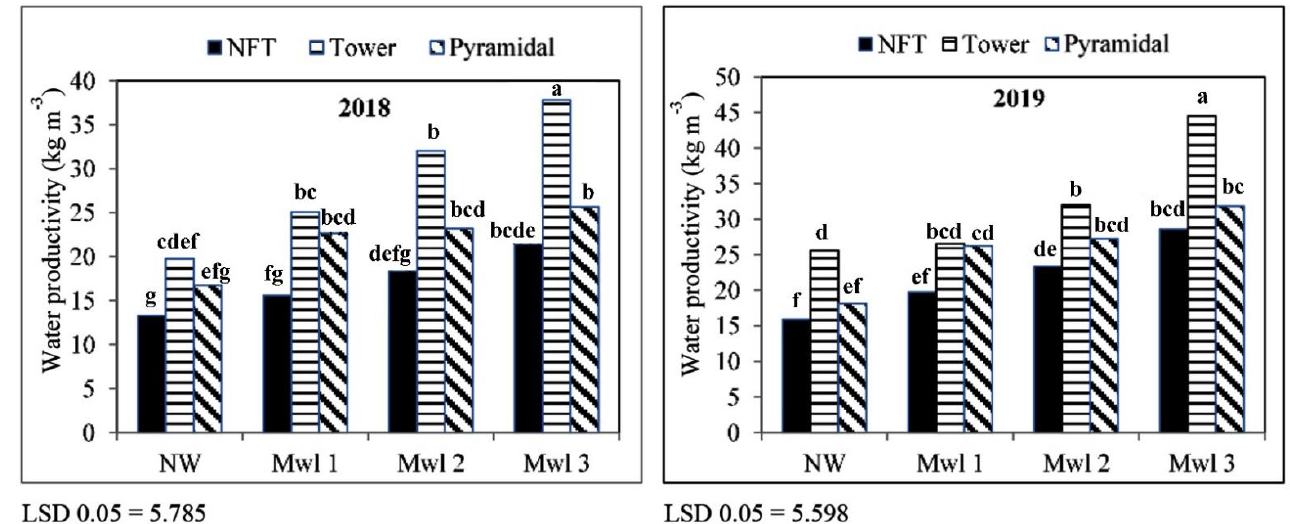
Figure 6. Water productivity of soilless culture systems under normal and magnetic water levels. Low- ercase letters a – e are homogeneous groups; means followed by the same letters are not significantly different from one another based on Duncan’s protected LSD test ( p ≤ 0.05